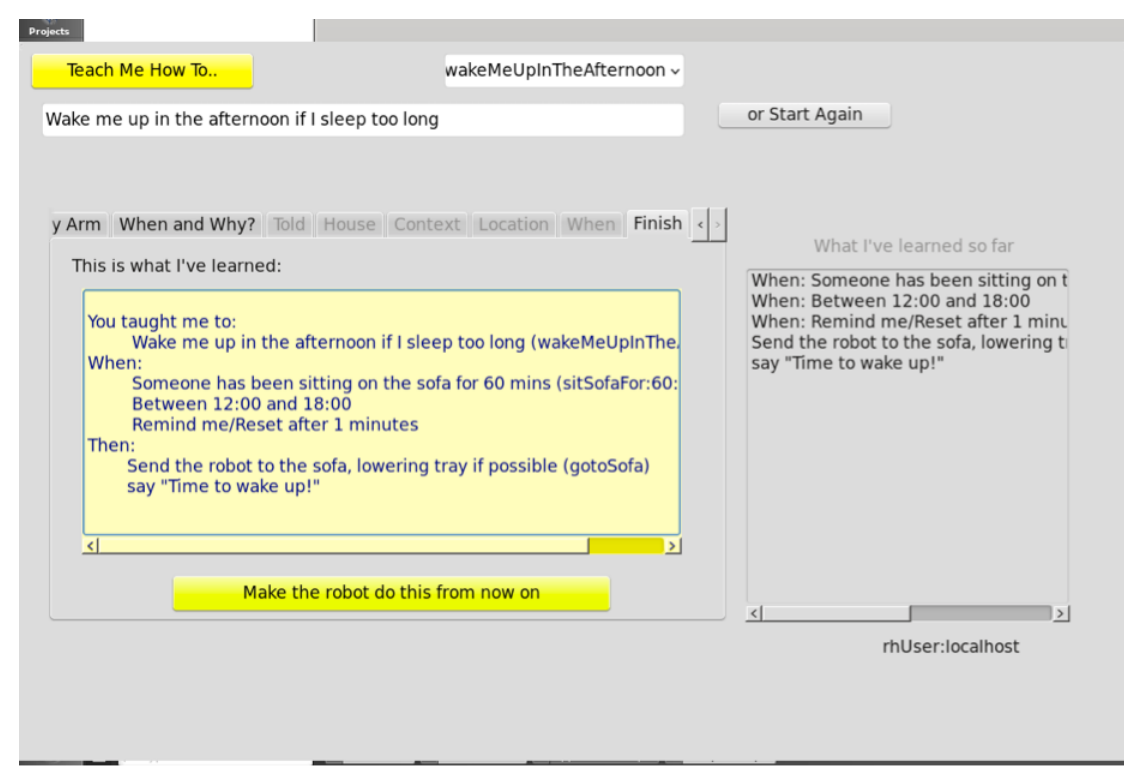
Figure 3. The TeachMe-ShowMe interface (only one screen shown) is a more abstract version of the ’sequencer’. The user exploits existing behaviours to create and scaffold new competencies on the robot. Behind the scenes the necessary supporting software and behavioural/logical pre and post conditions are generated